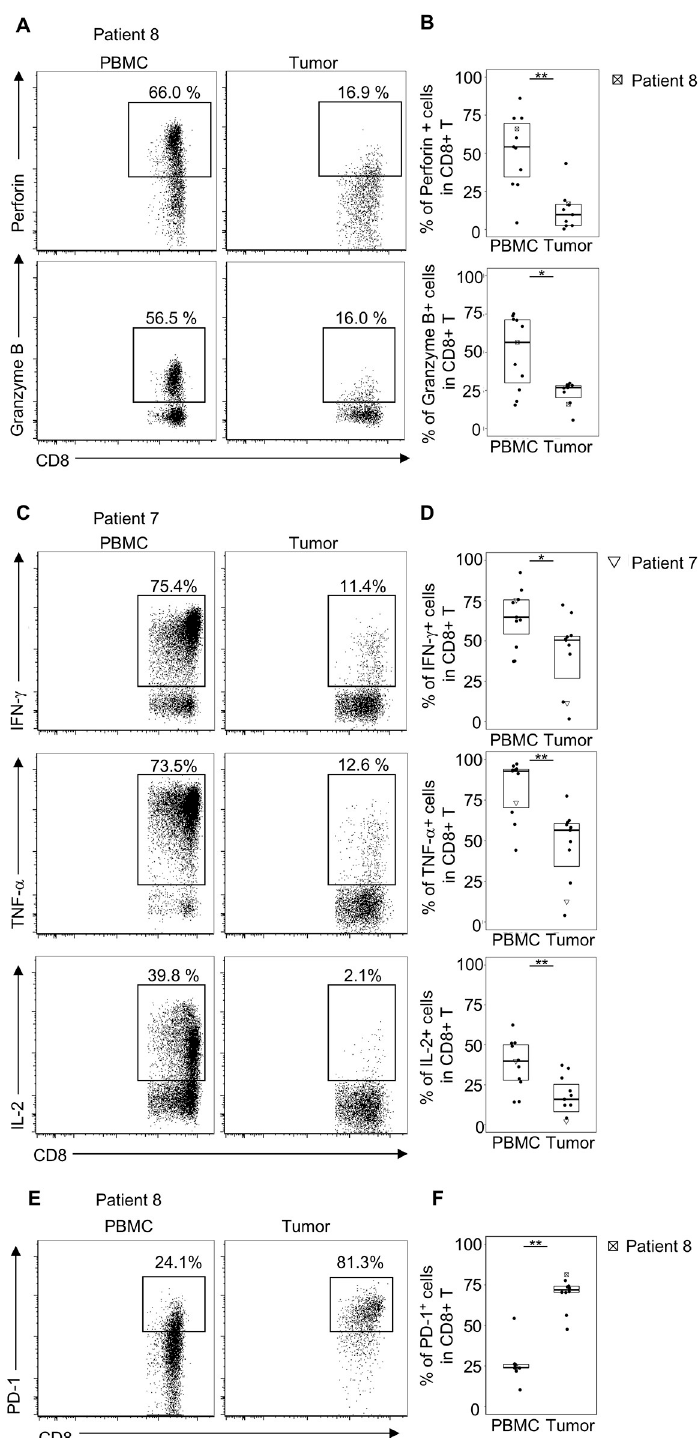
Fig 1. Flow cytometric analysis of perforin, granzyme B, IFN-g, TNF-a, IL-2, and PD-1 expression by CD8+ T cells in PBMCs and tumor tissues. Freshly isolated PBMCs and digested tumor tissues from 10 paired patients were stained by flow cytometry. Flow cytometric plots were pregated on TCRab+CD8+cells, excluding dead cells and na ï ve T cells (CD45RA+CCR7+ T cells). (A) Flow cytometric plots of perforin and granzyme B intracellular staining among CD8+ T cells are shown. (B) The frequencies of the expression levels of perforin and granzyme B in CD8+ T cells